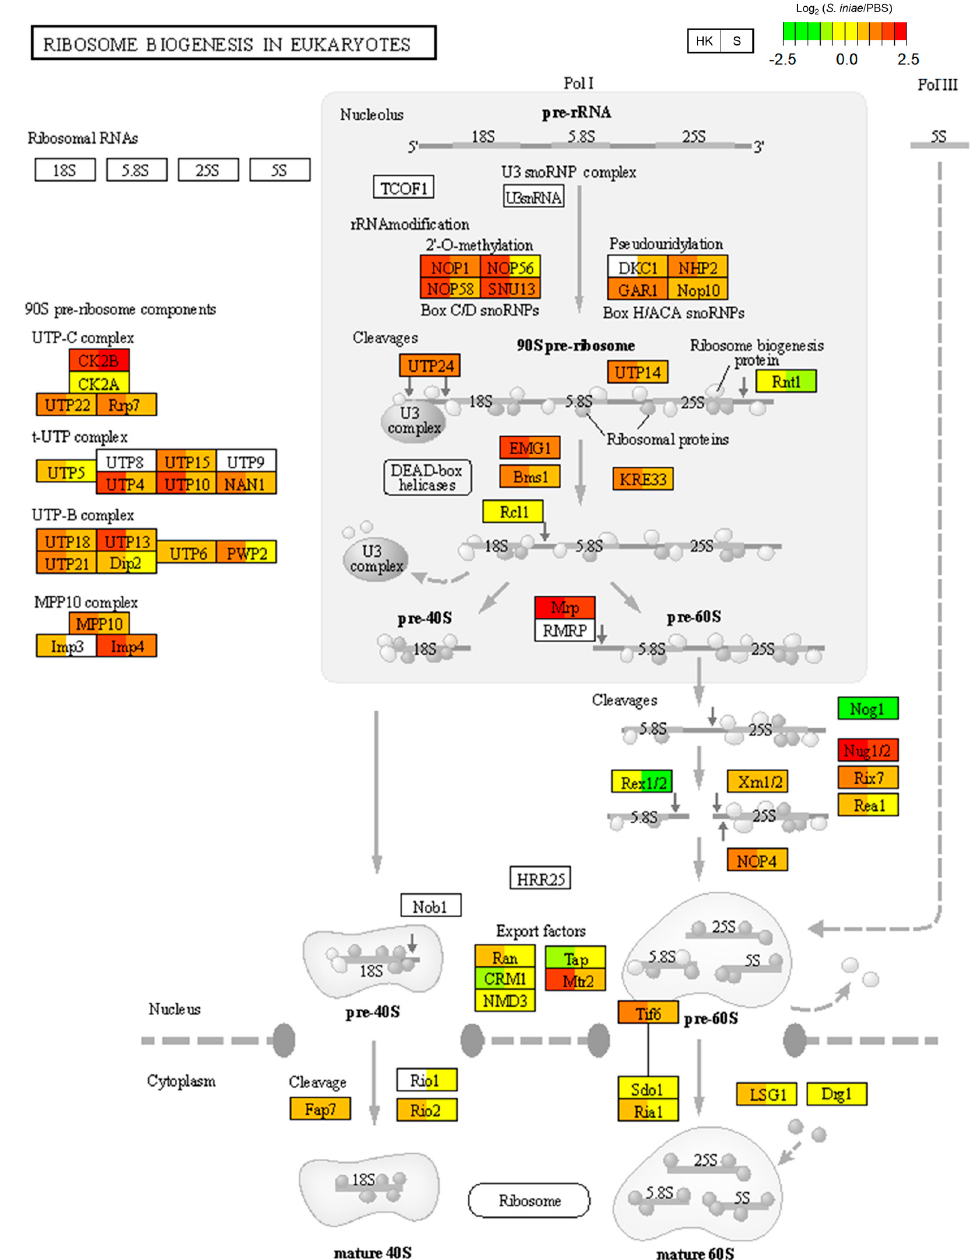
Figure 3. Ribosome biogenesis in eukaryotes in KEGG pathway maps (ko03008). Relative gene expression levels in the Streptococcus iniae -infected and phosphate-buffered saline (PBS)-treated groups are shown in the KEGG pathway map of ribosome biogenesis in eukaryotes (ko03008). The gene expression levels for the two groups, head kidney (HK) and spleen (S), are shown in each gene box. The higher expression levels are shown in red and the lower expression levels are shown in green. Undetected genes are shown in white.